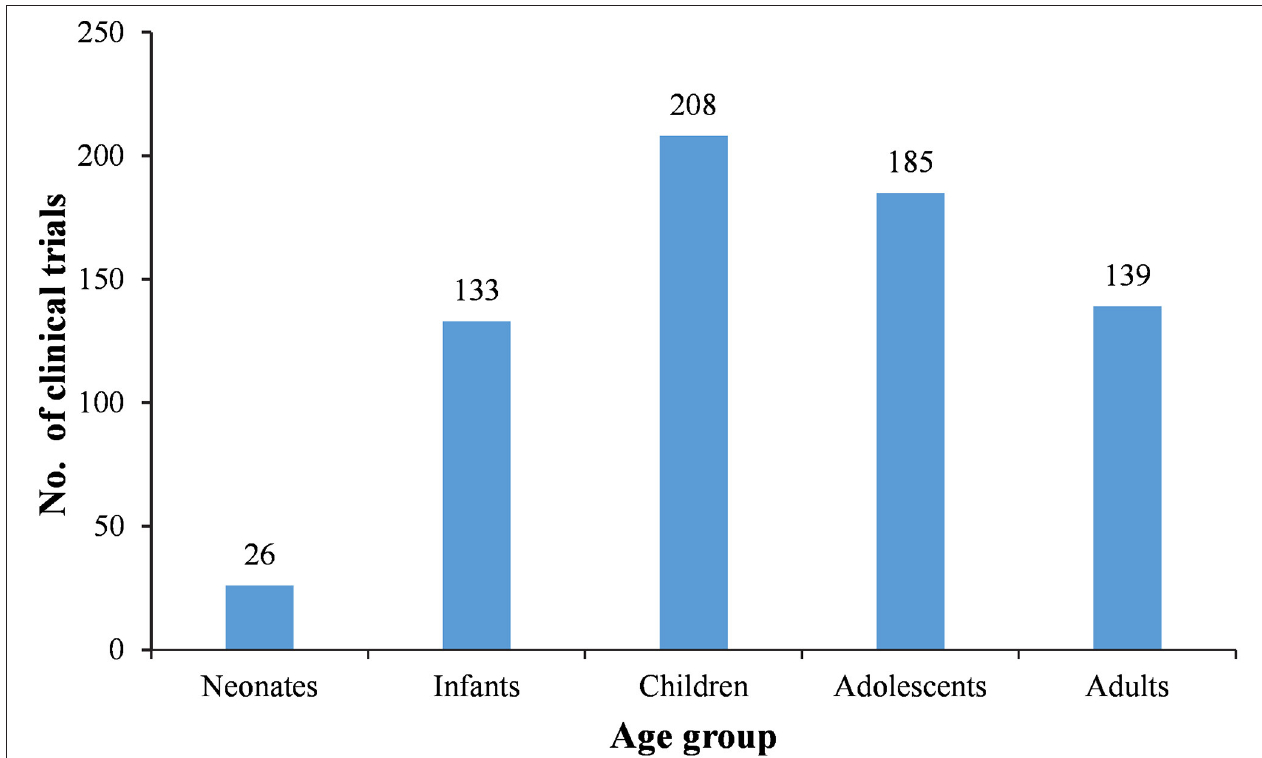
FIGURE 4 | Distribution of pediatric clinical trials by age